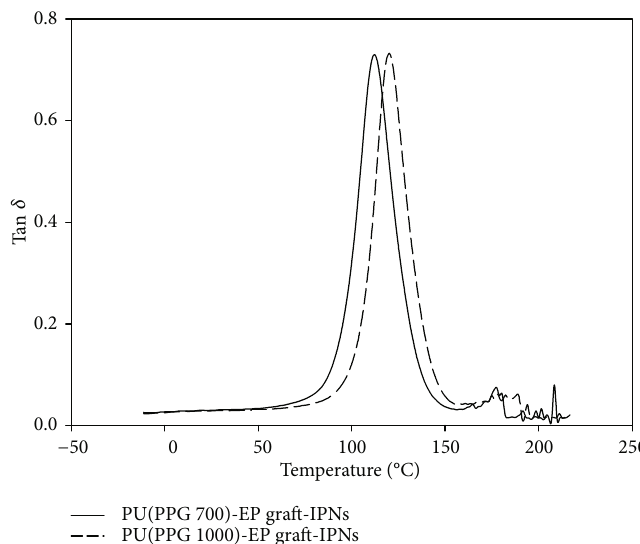
Figure 2: Tan δ of neat PU-EP grafted-IPNs by DMA (solid line represents PPG 700 PU-EP, and dash line represents PPG 1000 PU-EP).